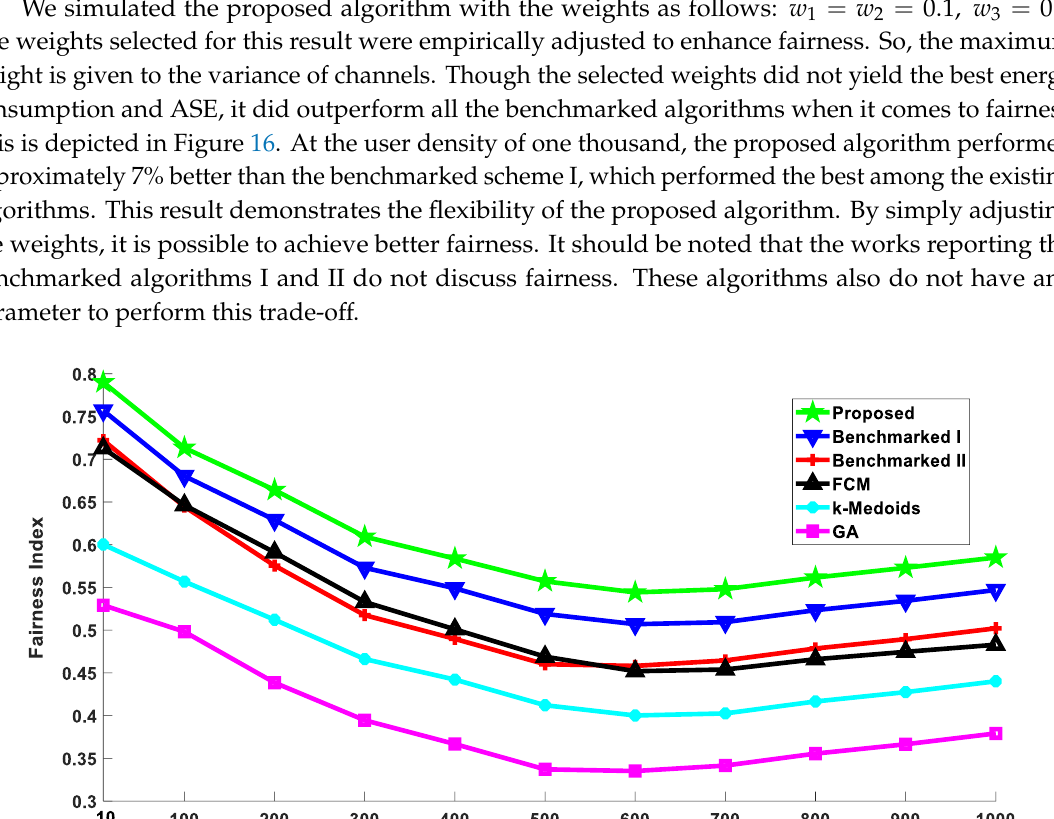
Figure 17. Energy consumption: comparison with the benchmarked schemes ( 𝑤 1 = 𝑤 2 = 0.1,𝑤 3 = 0.8 ).